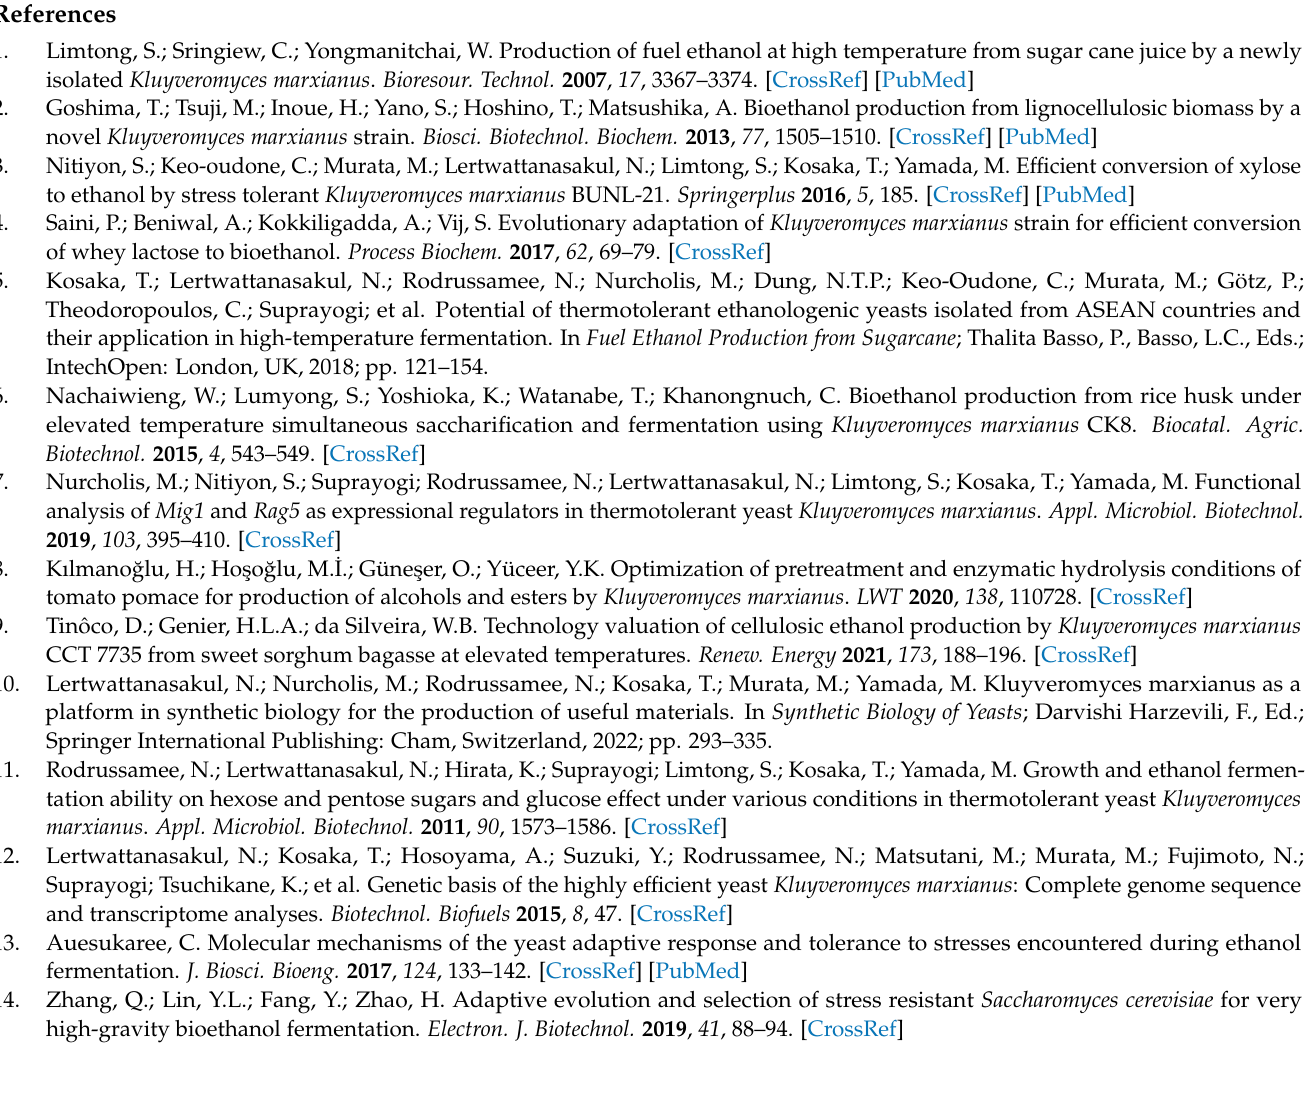
HPLC. Error bars represent ± SD of values from experiments performed in triplicate. Figure S4: Characterization of adapted strains. Growth of adapted strains on YP agar plates supplemented with 10% xylose and YPD agar plates supplemented with 35% glucose or 5 mM H 2 O 2 were compared. The plates were incubated at 30–45 ◦ C for 48 h; Table S1: Primers used in this study. Table S2: Comparison of evolutionary adaptation in this study with evolutionary adaptations reported